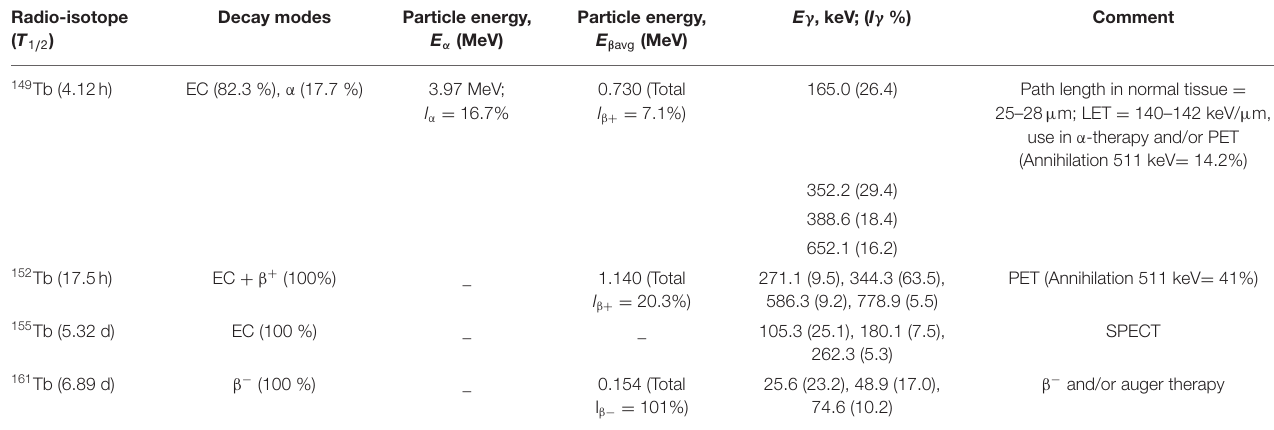
TABLE 2 | Properties of four terbium radioisotopes [21, 25]. Radio-isotope ( T 1 / 2